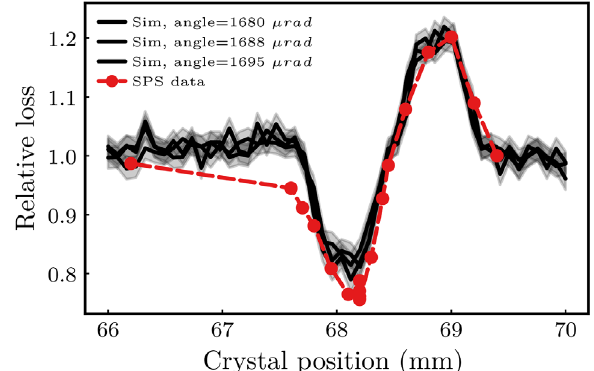
FIG. 16. Relative beam loss measured on the BLMs next to the ES as a function of the crystal position when aligned to the beam in volume reflection. Simulations for different angles are plotted to show the fluctuations in losses with the chosen angle, as this contributes to the uncertainty in the prediction of the loss reduction. The horizontal axis is expressed in MAD-X reference system.